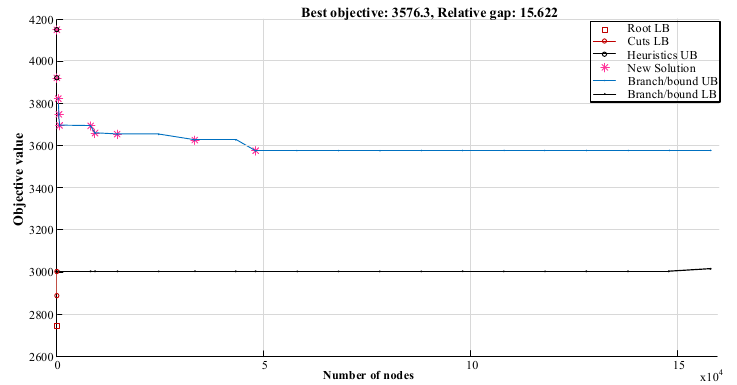
Fig. 10. Normal demand fulfillment results of Intlinprog solver